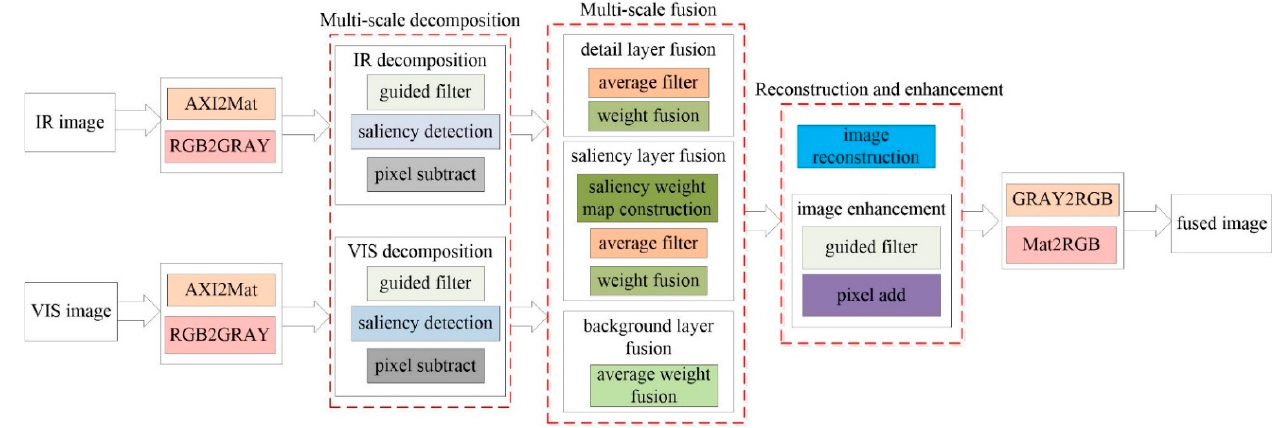
Figure 5. Schematic illustration for the top design of the image fusion module.